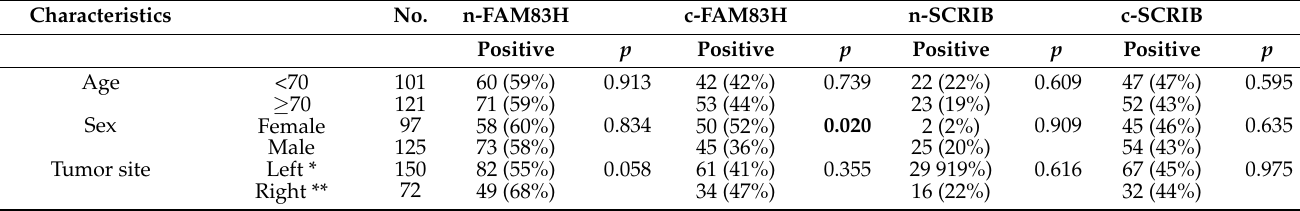
Figure 1. Immunohistochemical staining for FAM83H and SCRIB and statistical analysis in CRCs. ( A ) Immunohistochemical expressions of FAM83H and SCRIB in normal and CRC tissue. FAM83H and SCRIB were expressed in the cytoplasm and nuclei of the CRC cells. ( B ) The expression of the mRNA of FAM83H and SCRIB in normal colonic tissue and colorectal carcinoma tissue from the GEPIA2 database (http://gepia2.cancer-pku.cn, accessed on 23 June 2022) ( C ) Receiver operating characteristic curve analysis was performed to determine the positivity of the nuclear expression of FAM83H (n-FAM83H), cytoplasmic expression of FAM83H (c-FAM83H), nuclear expression of SCRIB (n-SCRIB), and cytoplasmic expression of SCRIB (c-SCRIB). The blue arrowhead indicates the cut-off point for n-FAM83H expression, and the empty blue arrowhead indicates the cut-off point for c-SCRIB expression. The red arrow indicates the cut-off point for n-SCRIB expression, and the open red arrow indicates the cut-off point for c-SCRIB expression. The cut-off points were determined to predict the deaths of CRC patients, and the points have the highest area under the curve (AUC). Table 1. Association between the expressions of FAM83H and SCRIB with clinicopathological characteristics of 122